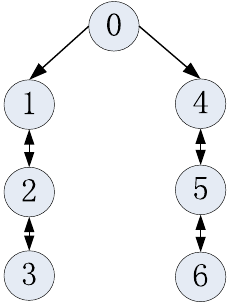
Figure 1. The MAS’ communication